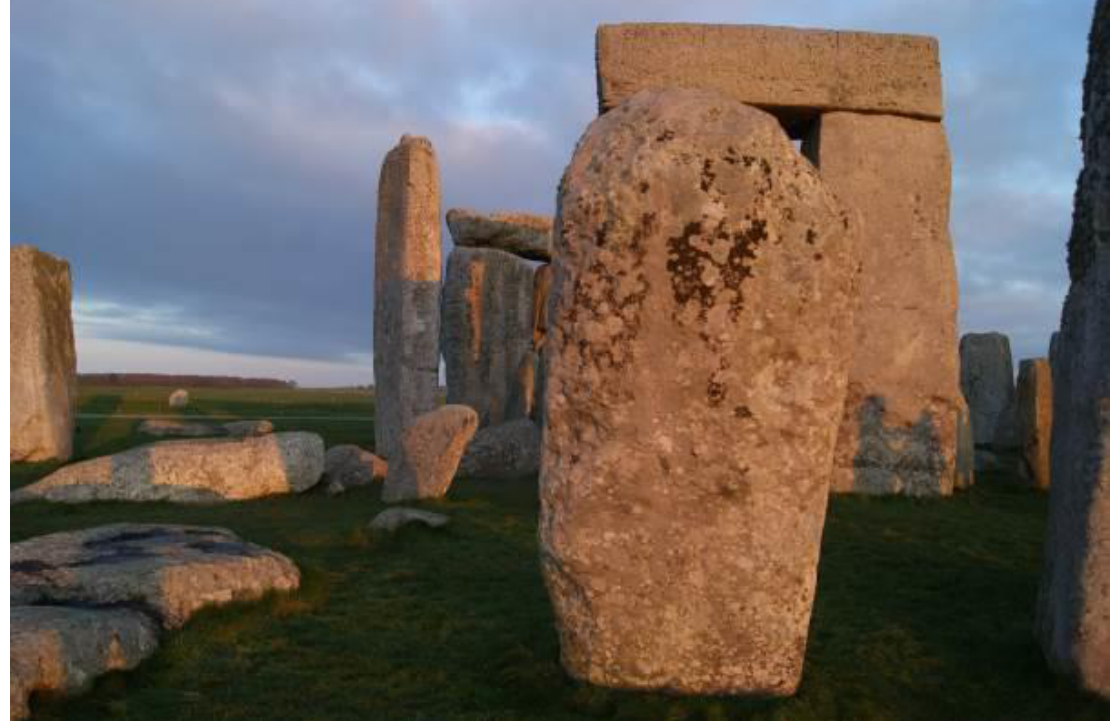
Figure 11. After a reddish sunrise on 27 December 2014, the shadow of the round-topped Stone 11 (the foreground stone) falls in the direction where part of Bluestone 40 lies just beyond the prone sarsen Stone 14 that has toppled inwards on top of the broken Bluestone 38. The latter and Bluestone 40 may be parts of what used to be a single stone. Compare with Figure 12. (Photograph by the